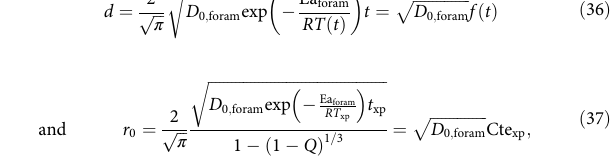
in which all the constant parameters of Eq. (15) but Cte xp